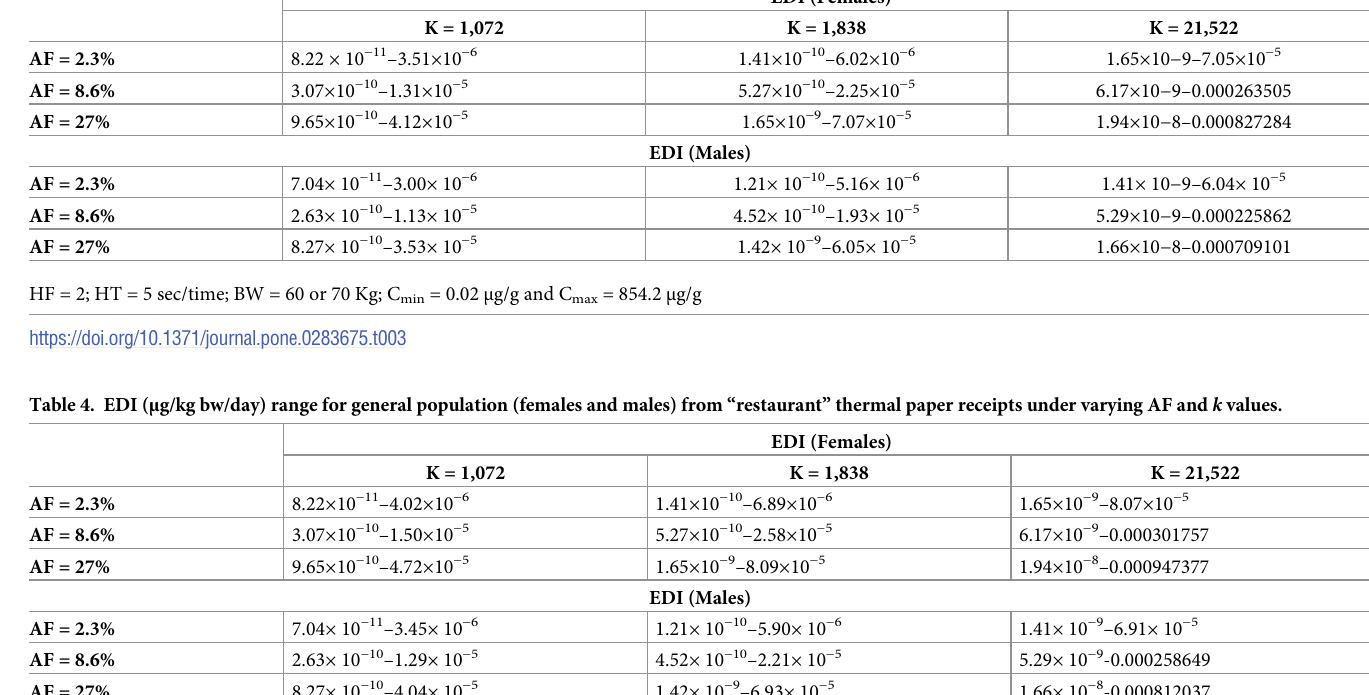
Table 5. EDI ( μ g/kg bw/day) range for general population (females and males) from “ATMs” thermal paper receipts under varying AF and k values.